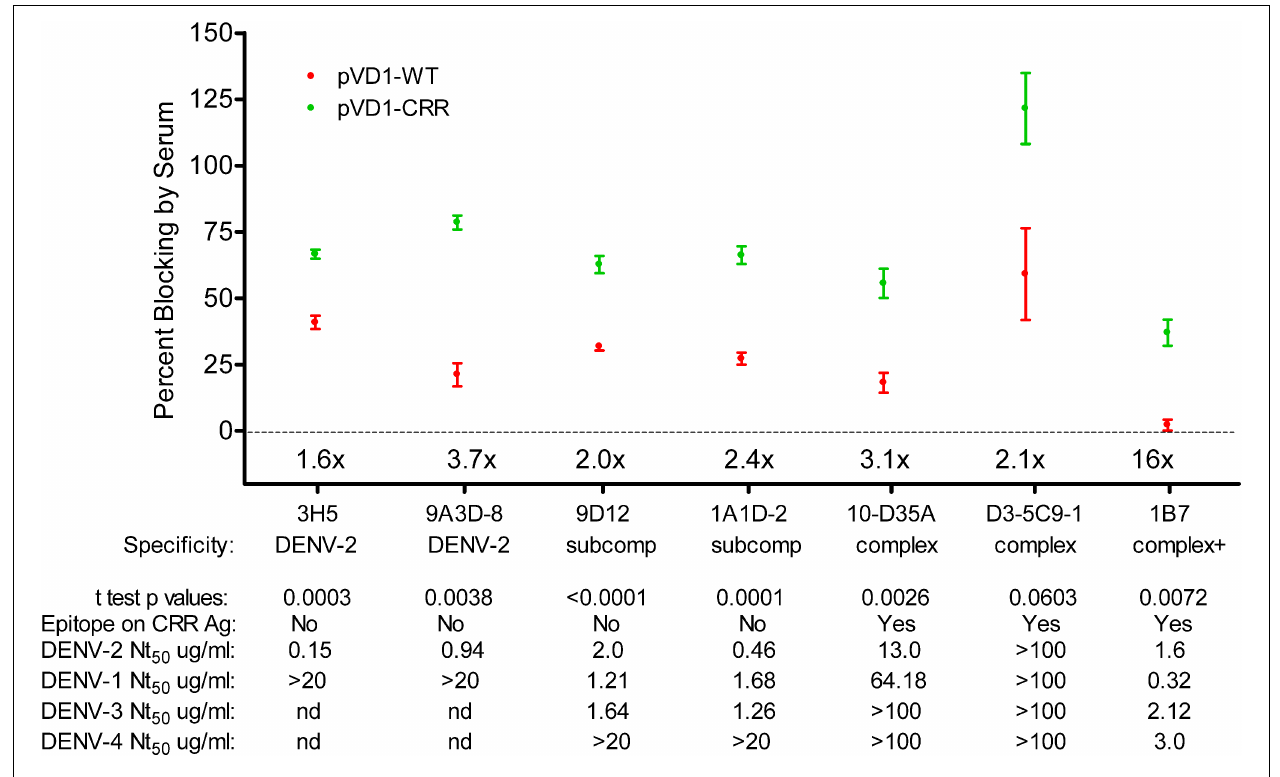
FIGURE 6 | DENV-1 CRR vaccination redirects immune responses to DENV-2 to increase a diversity of neutralizing antibodies. Percent blocking of labeled monoclonal antibodies (MAbs) by pVD1-WT and pVD1-CRR immunized mice 3 DPC to DENV-2 as determined by blocking ELISA. AG129 mice were immunized (i.m.) with 100 μ g of pVD1-WT or pVD1-CRR vaccines and challenged at 12 weeks with a sub-lethal dose of heterologous DENV-2 S221 (4.2 × 10 5 FFU, i.p.). 3 DPC sera of the four mice from each vaccine treatment were pooled and percent blocking was determined independently four times in duplicate.To facilitate comparison between vaccine treatments across the different MAbs, x-fold increases in blocking by pVD1-CRR vaccinated sera relative to pVD1-WT vaccinated sera are depicted above the x -axis for each MAb. Below the MAbs, serotype specificity is depicted (DENV-2, DENV-2 type-specific; subcomp, DENV sub-complex cross-reactive;